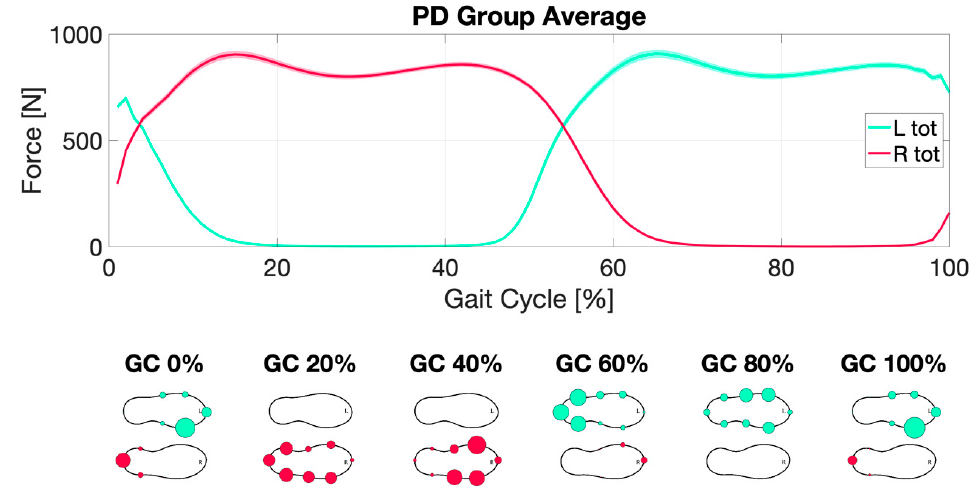
Figure 6. Healthy subjects gait dynamic. Right (R tot) (red line) and Left (L tot) (green line) total force averaged along gait cycles (GC) and subjects over the percentage of completion of the gait cycle (top). The bottom part of the figure represents a graphical visualization of the force measured by the single sensors embedded within the instrumented insole: the larger the circles (right red; left green), the larger the force measured.